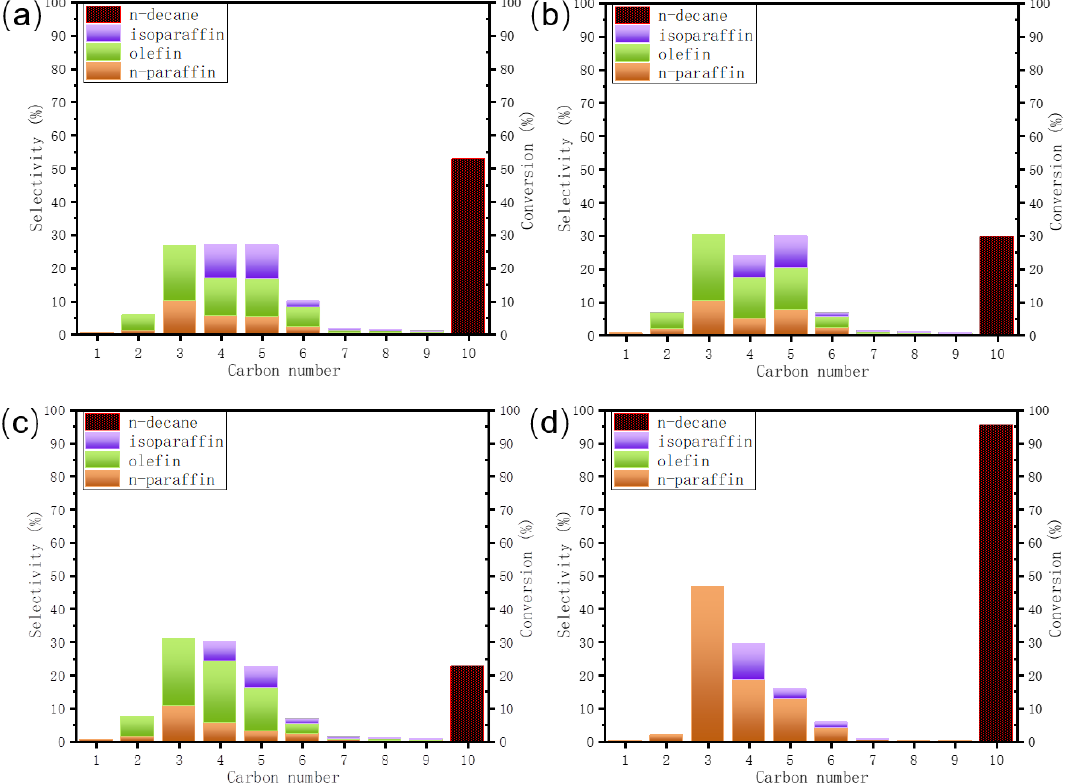
Figure 13. The conversion of the catalytic cracking of n-decane and the products distribution over ( a ) Z–M–Mg, ( b ) Z–M–Ca, ( c ) Z–M–Sr and ( d ) Z–M–Pd. The reaction conditions: Catalyst weight = 0.3 g, F C10 = 0.03 g/min, F gas = 20 mL/min, Reaction temperature = 400 °C, Pressure = 0.1 MPa. Table 6. The conversion of the catalytic cracking of n-decane and the products distribution a .